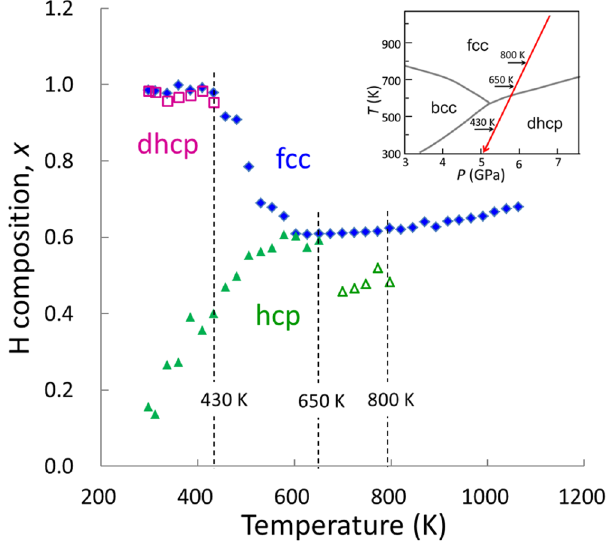
Figure 5. The x – T relations are shown for fcc (blue solid diamonds), hcp (green solid triangles), and dhcp (purple open squares) hydrides. The estimated compositions for the precipitated hcp hydride are represented by green open triangles. Vertical broken lines show the approximate precipitation, transformation, and decomposition temperatures. The inset shows the cooling T – P